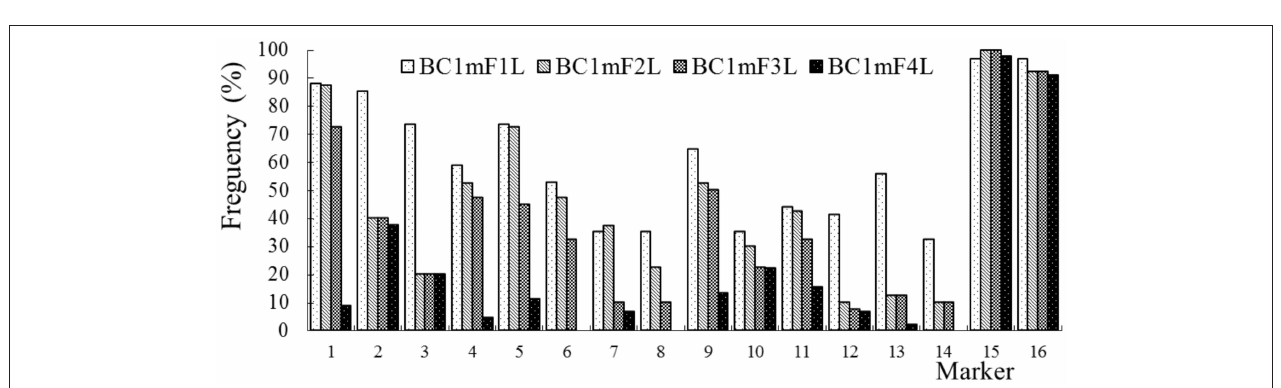
FIGURE 11 | Frequency of the marker specific to the C-chromosome of Brassica napus in the first (BC1mF1L)- to fourth (BC1mF4L)-generation progenies of BC1. BC1mF1L to BC1mF4L are the glufosinate-tolerant first- to fourth-generation progenies of the first backcross generation (BC1) obtained from wild Brassica juncea × F1L. F1L indicates the glufosinate-tolerant F1 hybrids obtained from wild B. juncea × glufosinate-tolerant transgenic oilseed rape. Progenitors in front of the × are always the maternal plants, and progenitors after the × are always the paternal